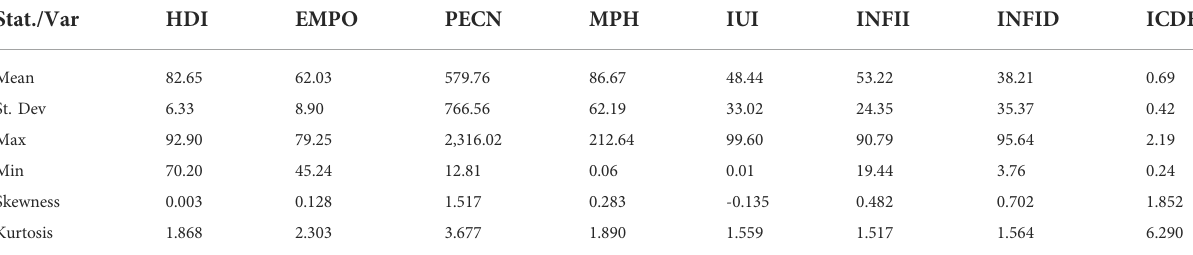
TABLE 2 Summarized